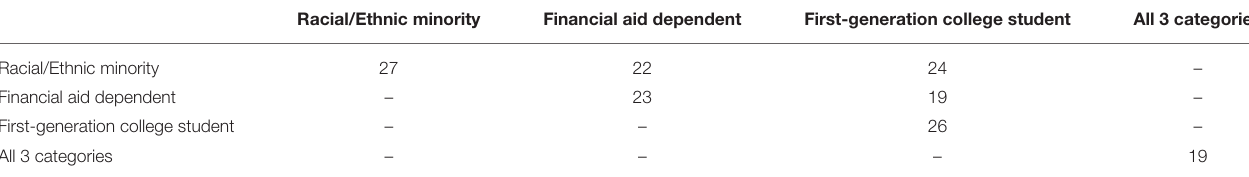
TABLE 1 | Demographic matrix of student